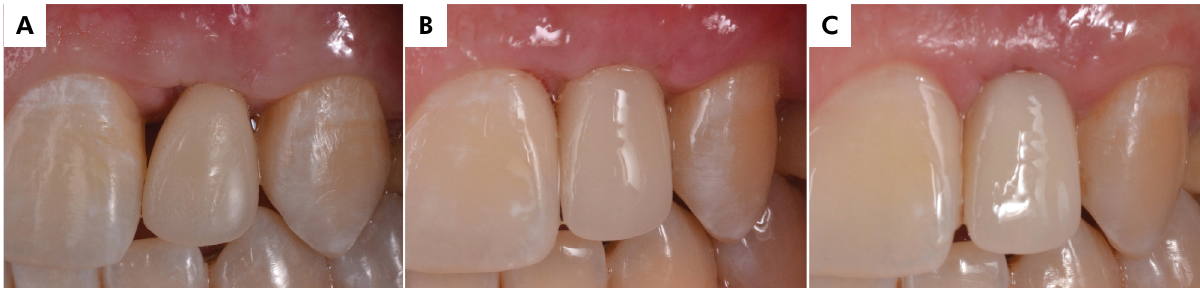
Figure 7. Clinical aspect prior to new restorations (a), immediately after (b) and one year later (c) showing the vertical growth of the papillae after surgical and restorative procedures.